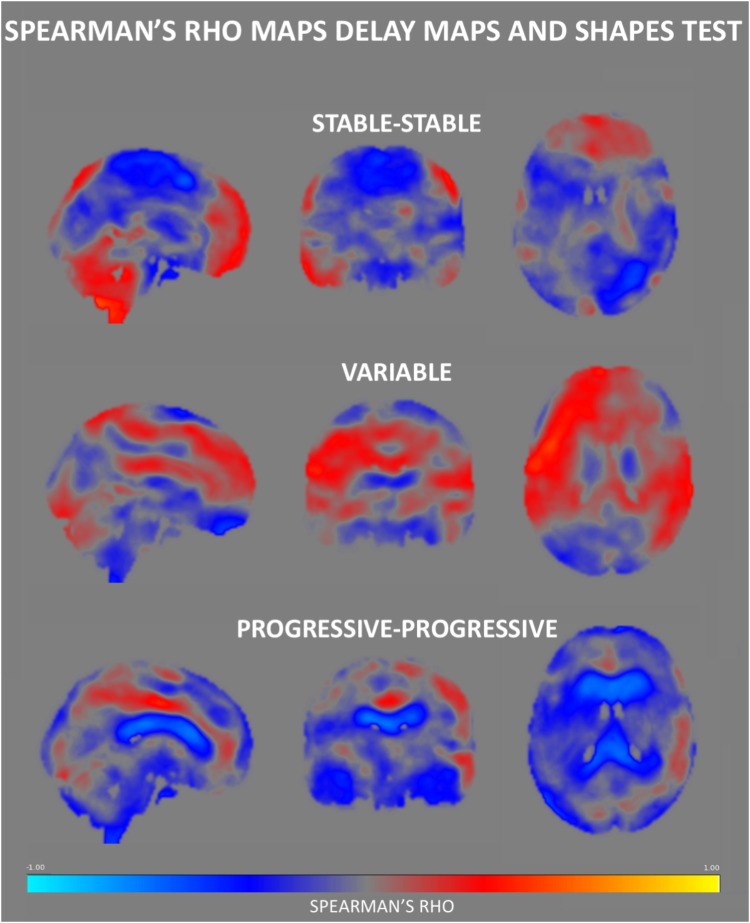
Spearman’s rho correlation maps between ASL values and the Shapes test performance. A predominance of negative associations was found in the SS group, with positive correlations residing in the frontal and cerebellar regions. The PP group also displays a negative association in most of the brain areas especially in regions surrounding the ventricles. Interestingly, the Spearman rho maps of the V group show global prominent positive correlations in areas that show negative rho values in the SS group, residing largely in the medial part of the brain.